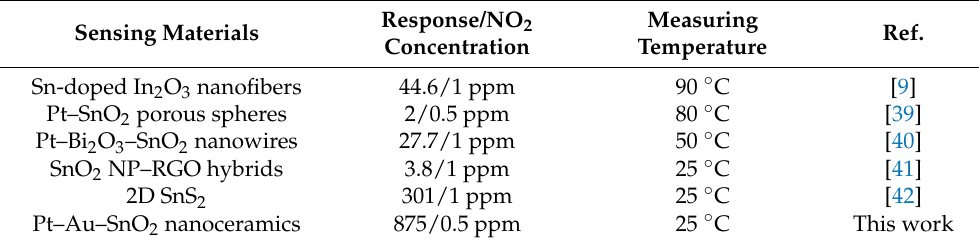
Figure 4. Resistance response to a series of concentrations of NO 2 in 20% O 2 –N 2 at room temperature and recovery in the air of 50% RH, for a sample of 1 wt% Pt–5 wt%Au–SnO 2 sintered at 950 ◦ C for 2 h the in air. Table 1. Performances of representative low-temperature NO 2 -sensing materials.